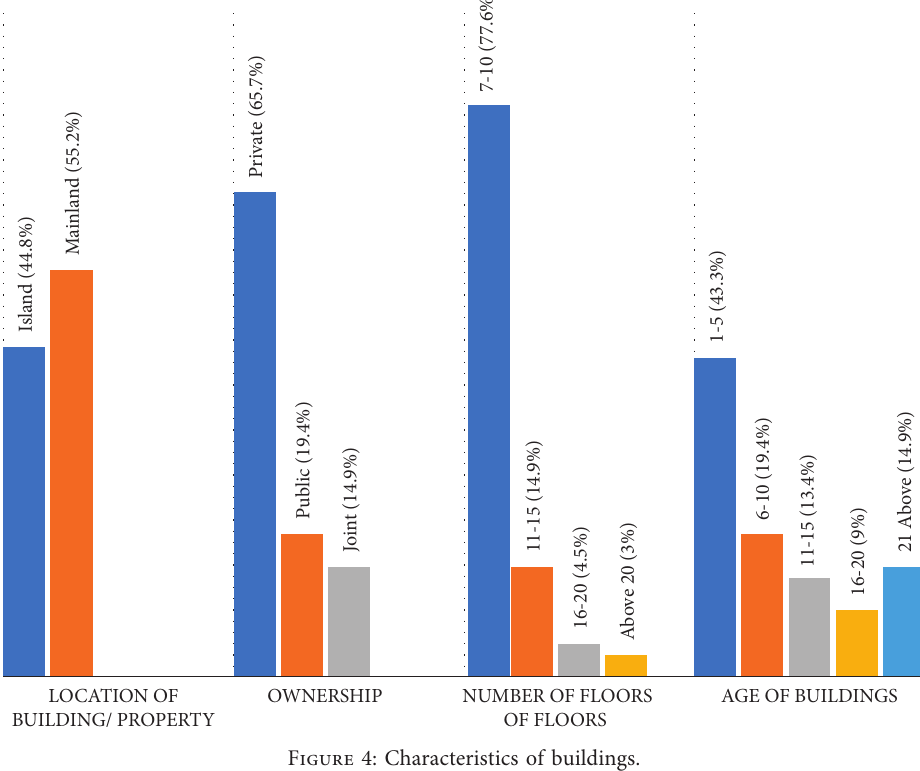
Figure 4: Characteristics of buildings.